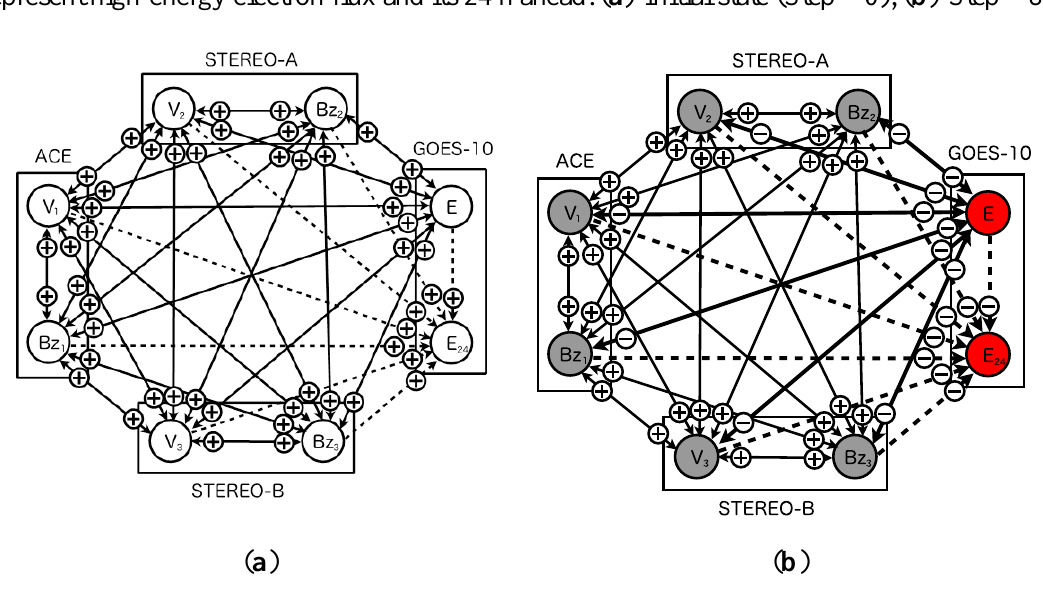
Figure 9. Snapshot of nodes in the dynamic relational network (eight-sensor model). The nodes evaluated as faulty from all sensors are colored red. The nodes evaluated as faulty from half nodes are also colored red. The plus and minus signs on arcs represent a diagnosis result (plus = normal/minus = abnormal). Rectangles represent regions of satellites equipped with sensors for observation. The solid lines indicate two nodes diagnose each other. The dashed lines indicate unidirectional diagnosis from one node to another one. The symbol V and B ( i = 1, 2, 3) respectively represent solar wind speed and i zi north-south component of interplanetary magnetic field. The symbol E and E respectively 24 represent high-energy electron flux and its 24 h ahead. ( a ) Initial state (Step = 0); ( b ) Step =